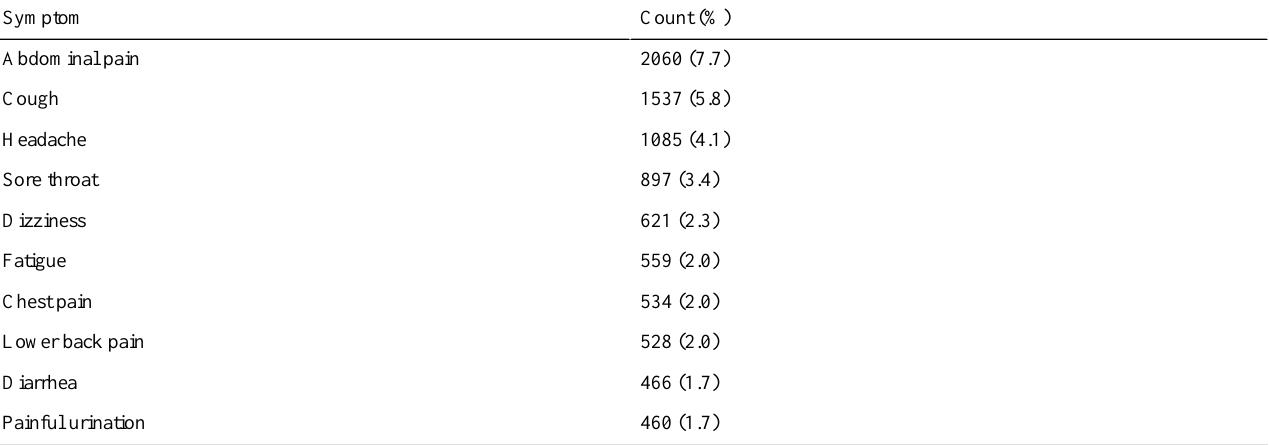
Table 2. The top 10 most common initial symptoms reported in the symptom checker (N=26,646).